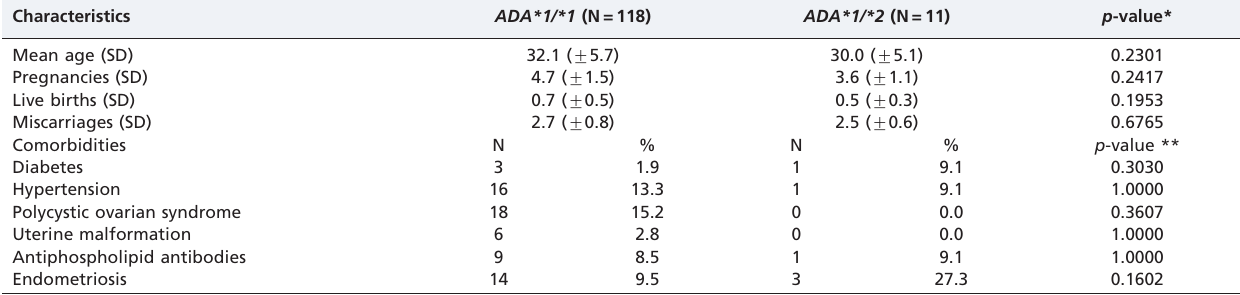
Table 3 - The demographic characteristics, reproductive histories and comorbidities of women who had suffered two or more recurrent spontaneous abortions according to the ADA*1/*1 and ADA*1/*2 genotypes (N= 129).